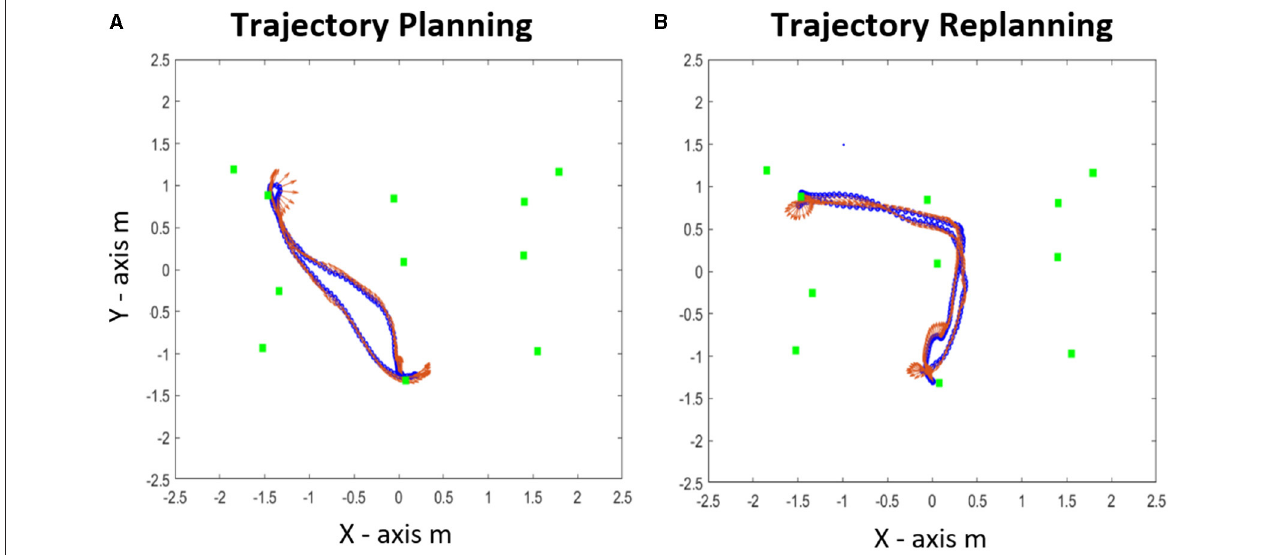
FIGURE 8 | Trajectories replanning examples. (A) Departure to previous learned direction (PLD) during replanning before the treatment. (B) Departure to a new direction (ND) after the treatment. The red arrows represent the head direction of the trajectories during the replanning phase.